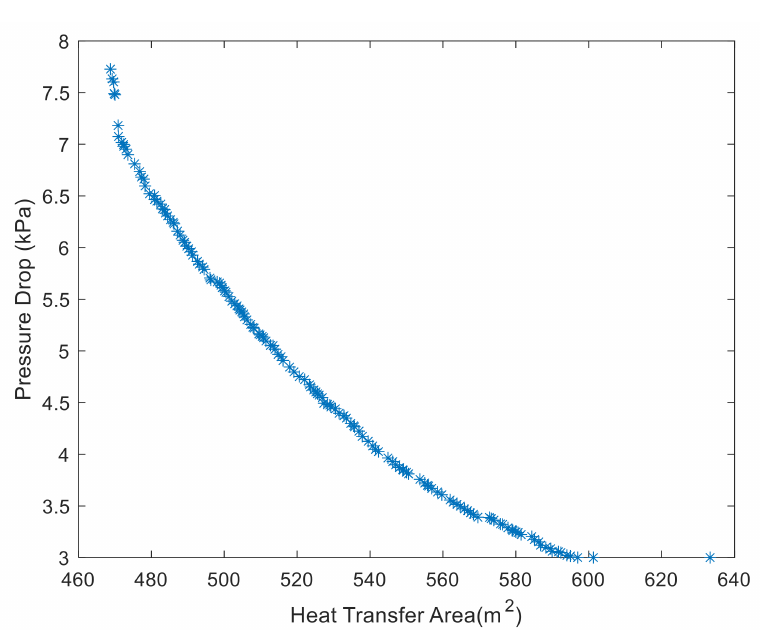
Figure 4. Pareto optimal frontier for heat transfer area and pressure drop of